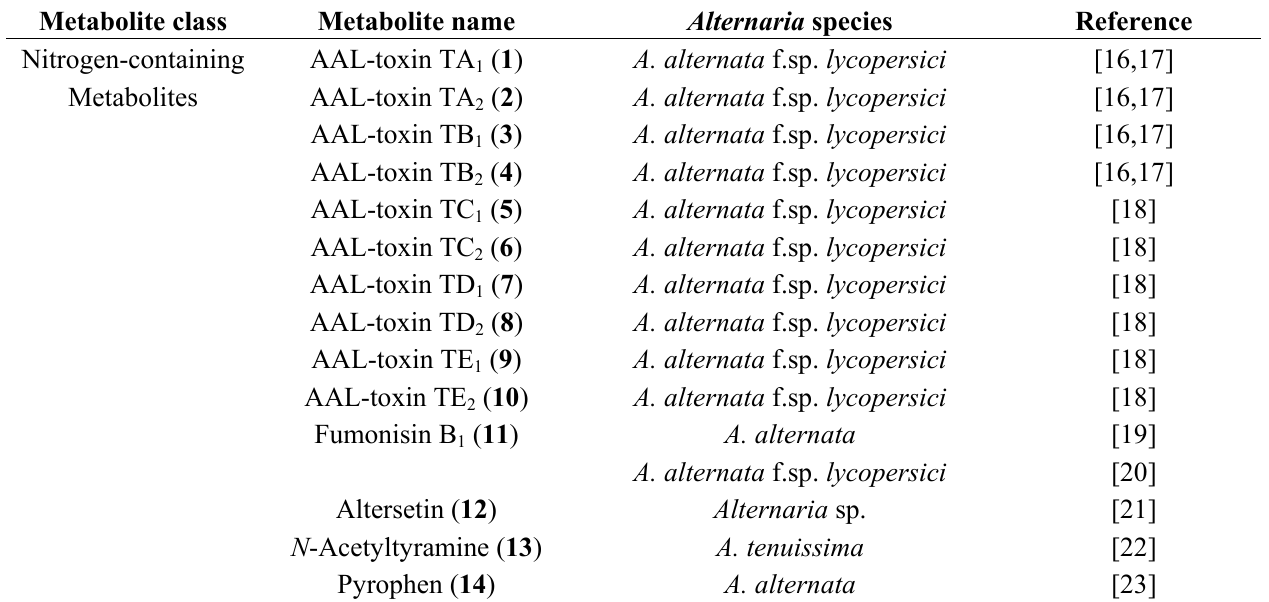
Table 1. The isolated metabolites and their occurrences in Alternaria